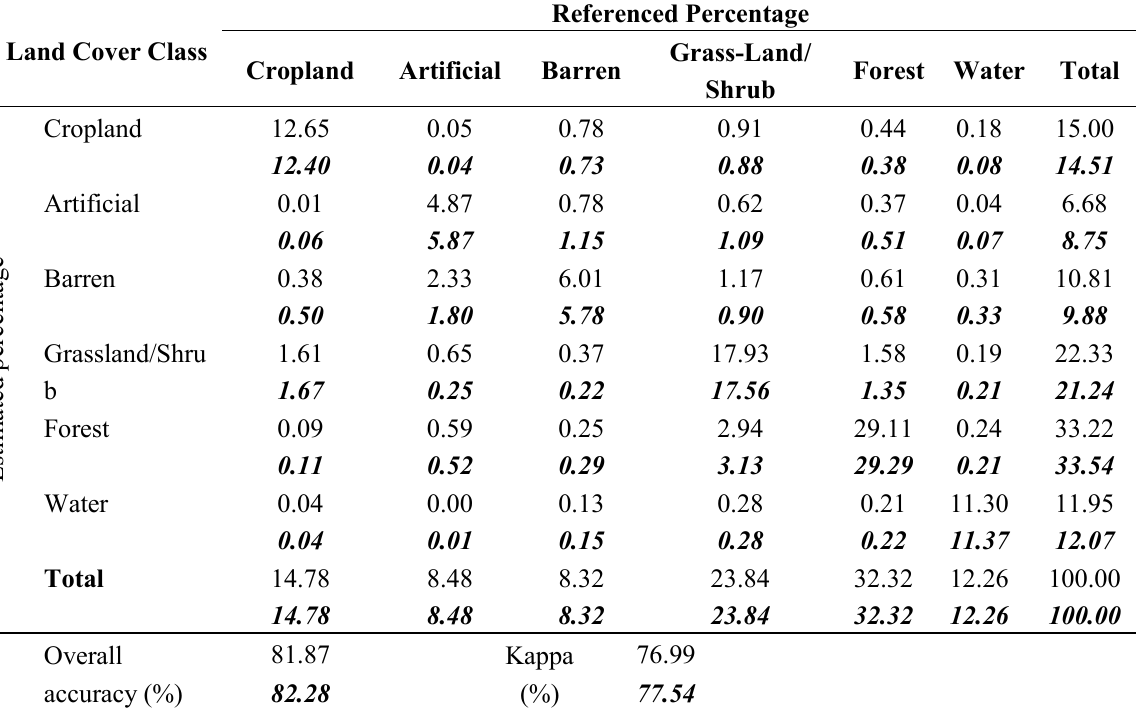
Table 2 . The overall cross tabulation matrix for the two classification methods: per-pixel (normal text) and sub-pixel (bold italicized